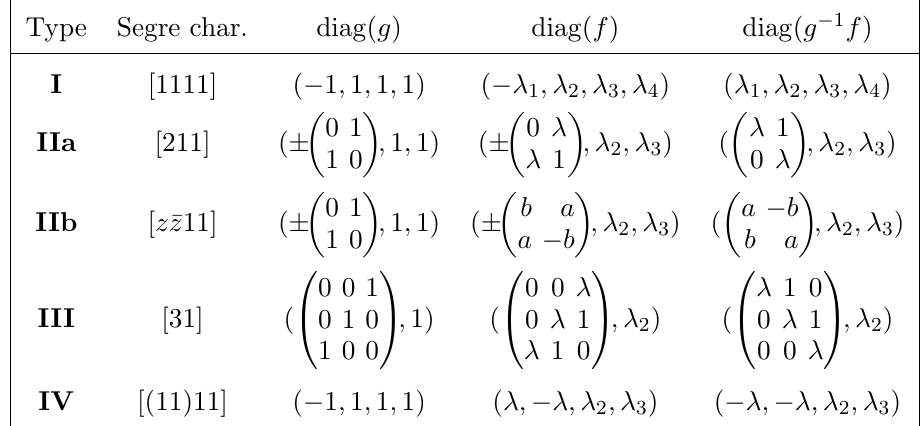
Table 1 . Overview of all possible metric con(cid:12)gurations for d = 4. One E with n = k k